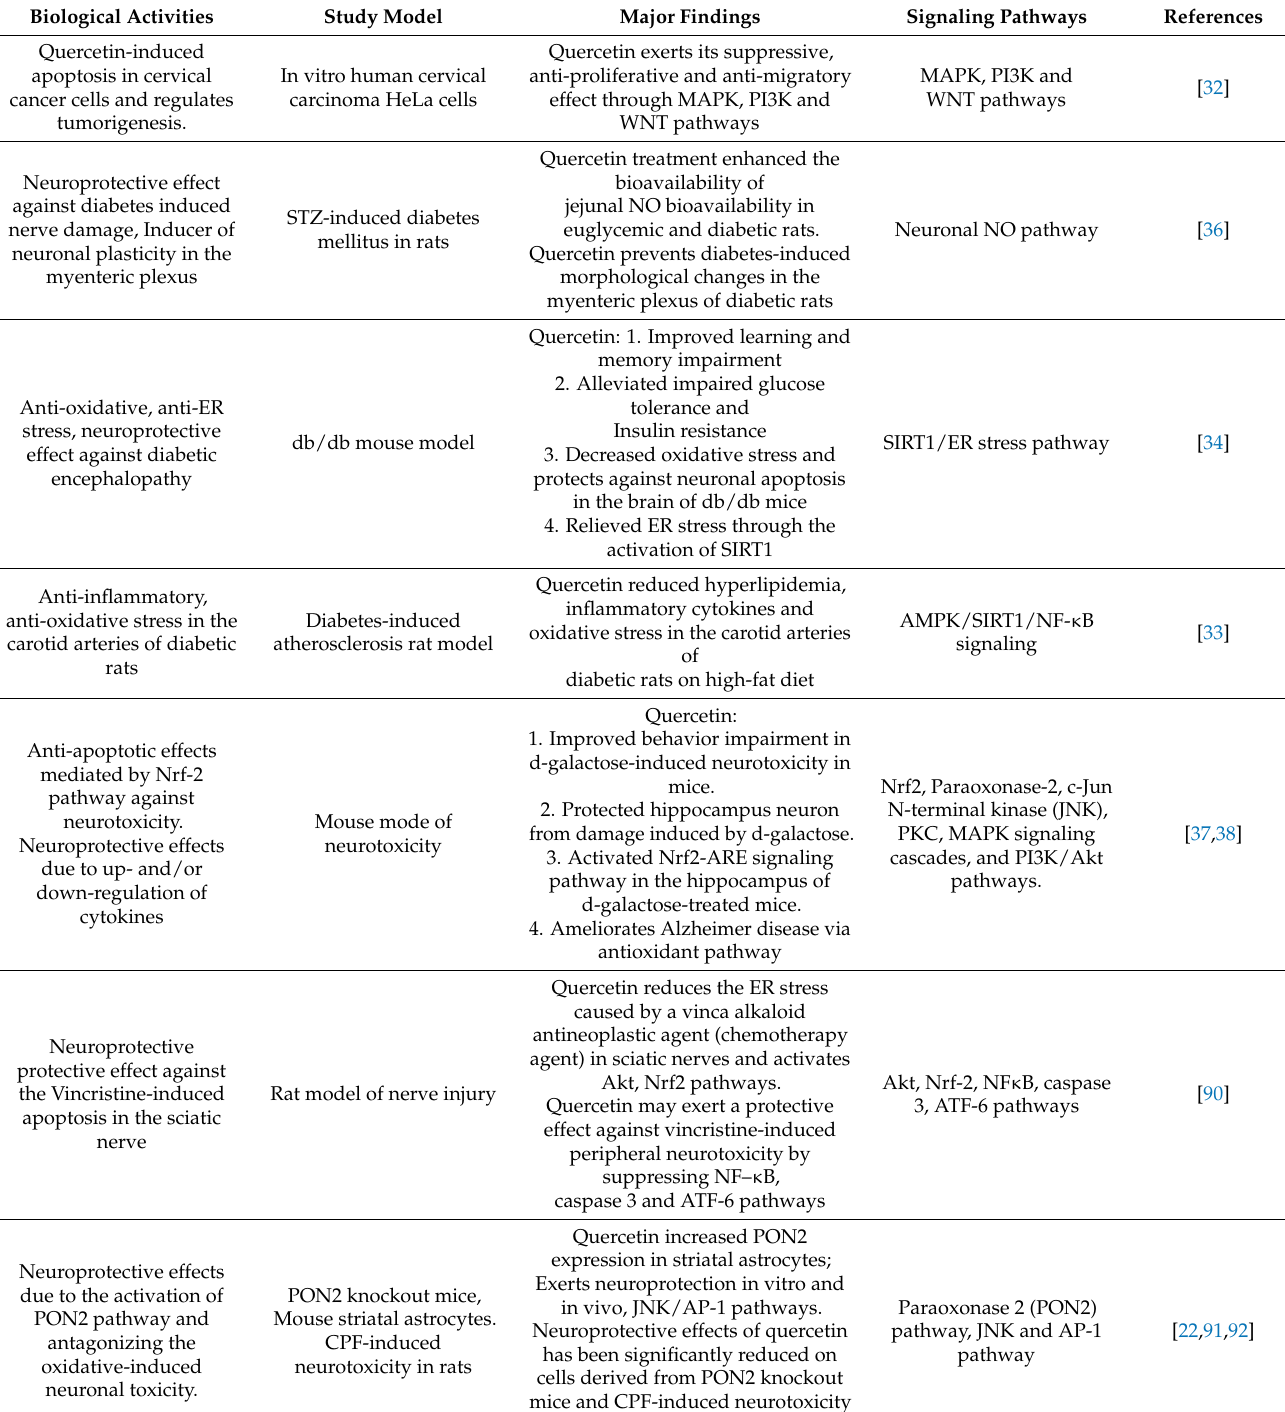
Table 1. Summary of the major effects of quercetin and their main targeted signaling pathways in vitro and in vivo